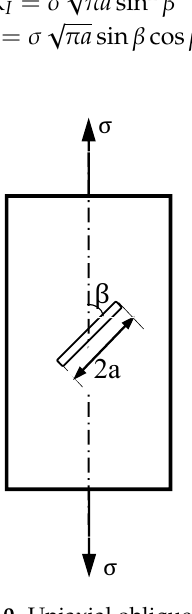
Figure 10. Uniaxial oblique crack.